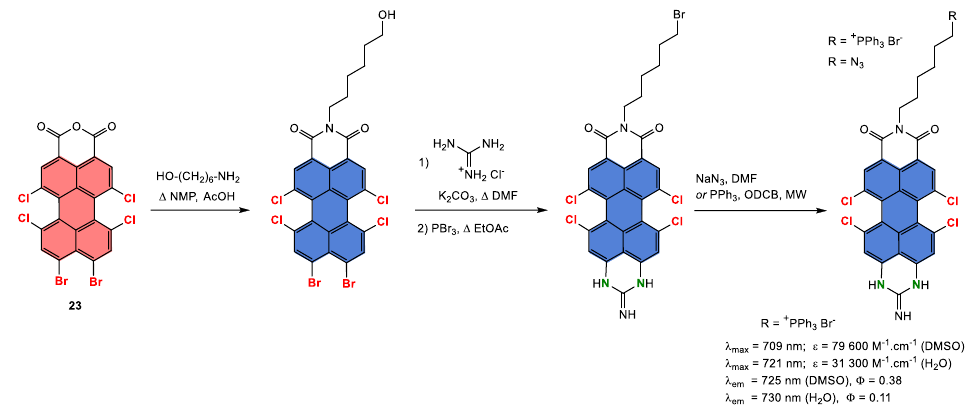
Scheme 13. Synthesis of PMI dyes substituted with a guanidyl group in peri